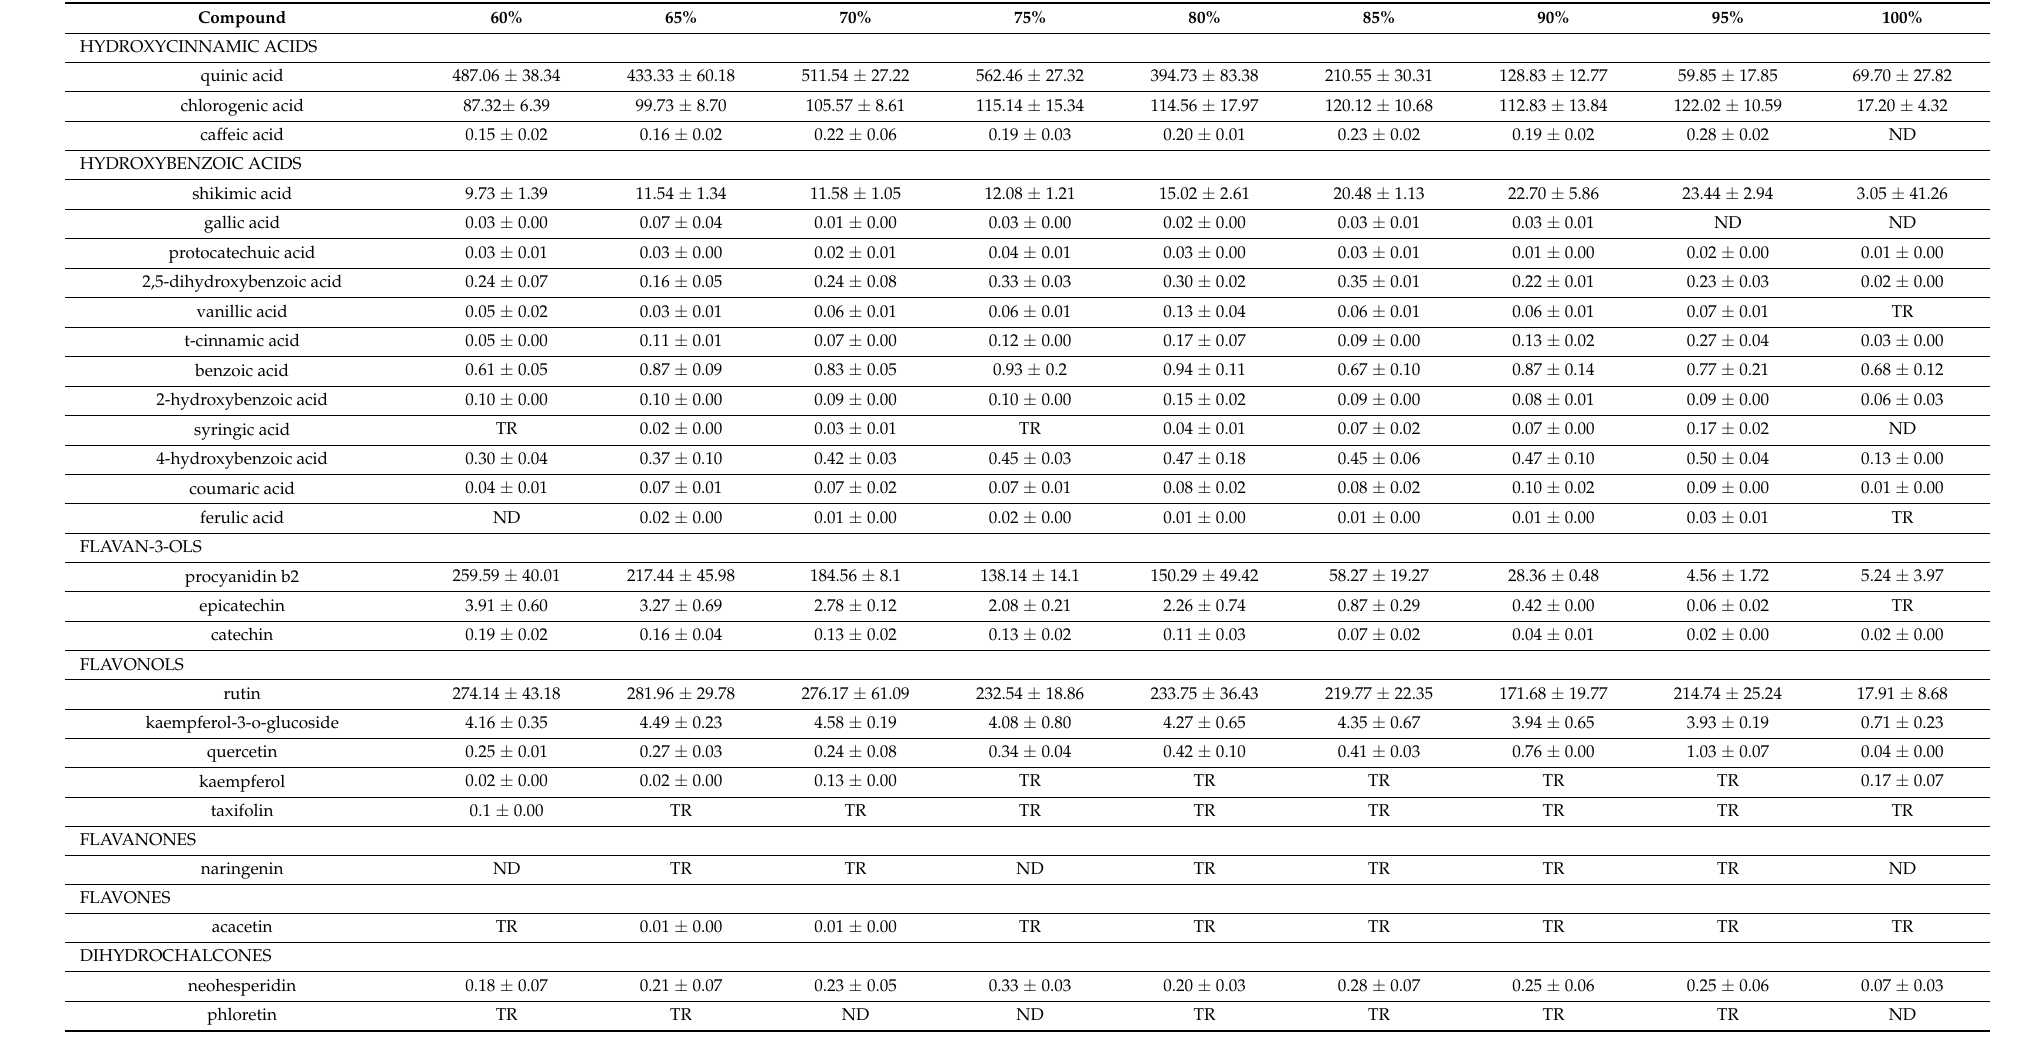
Table 2. Phenolic profile and content of aqueous acetone extracts obtained from Quince fruit ( Cydonia oblonga Mill.) by